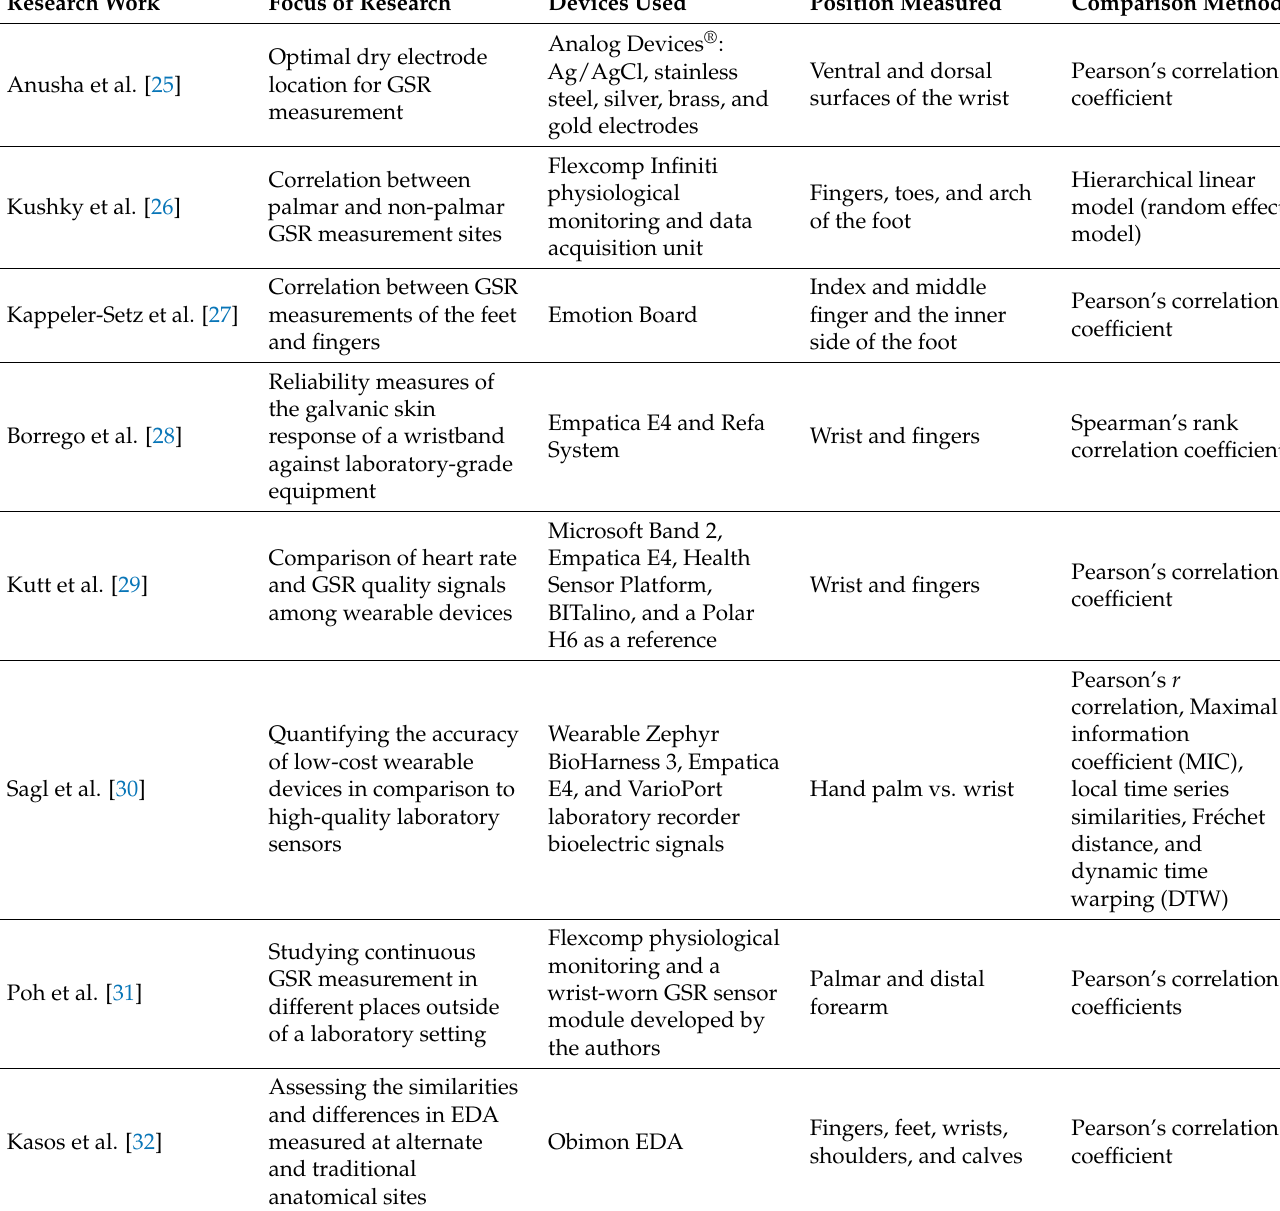
Table 1. A summary of the recent literature regarding GSR measurement places and physiological